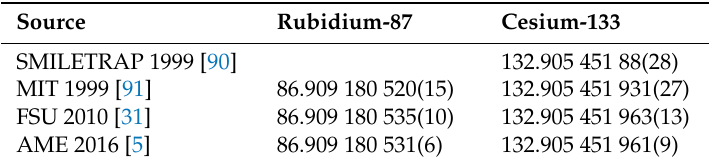
Table 9. Atomic mass values for 87 Rb and 133